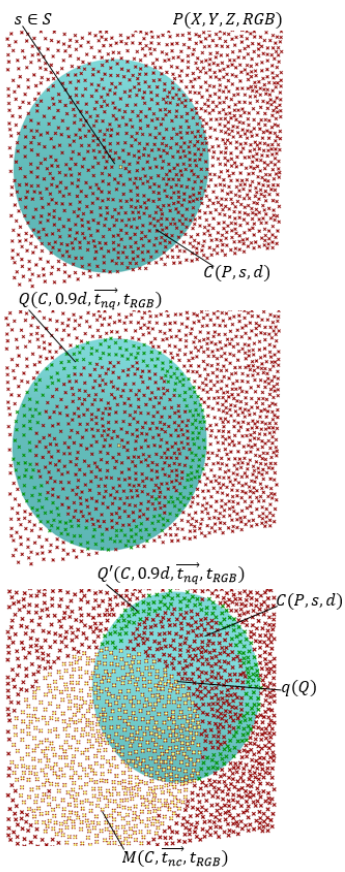
Figure 2 . Overview workflow Region Growing. Candidate seg- ment points C in P (top), Extraction of growing points Q from C (mid) and update of Q, M and C during each iteration